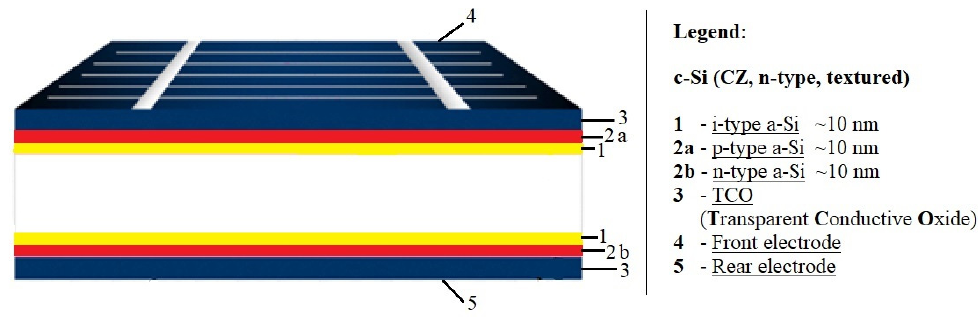
Figure 9. Structure of an HIT solar cell [30].